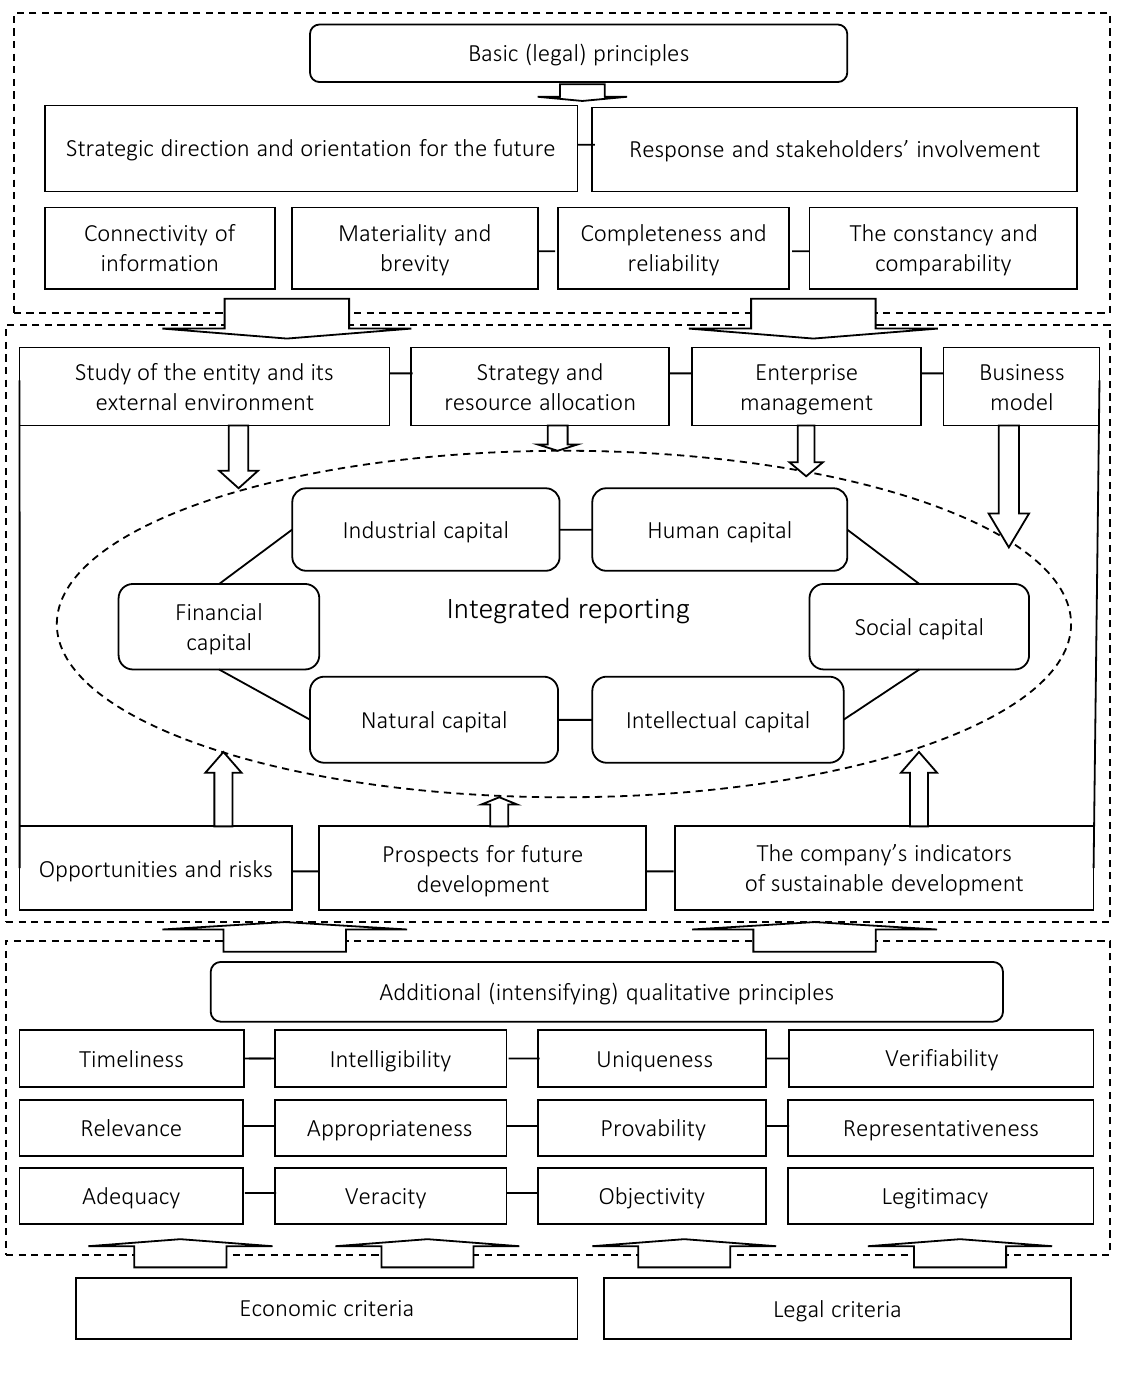
Figure 2. The concept of creating an integrated reporting model in